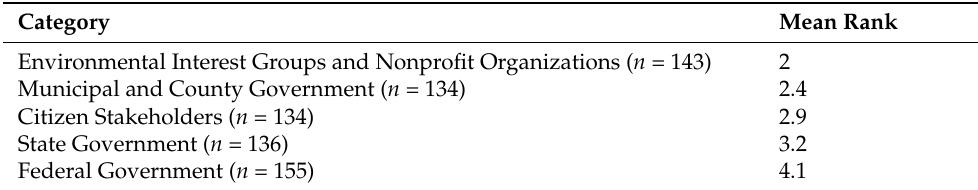
Table 5. Ordered logistic regression results . OLR Model